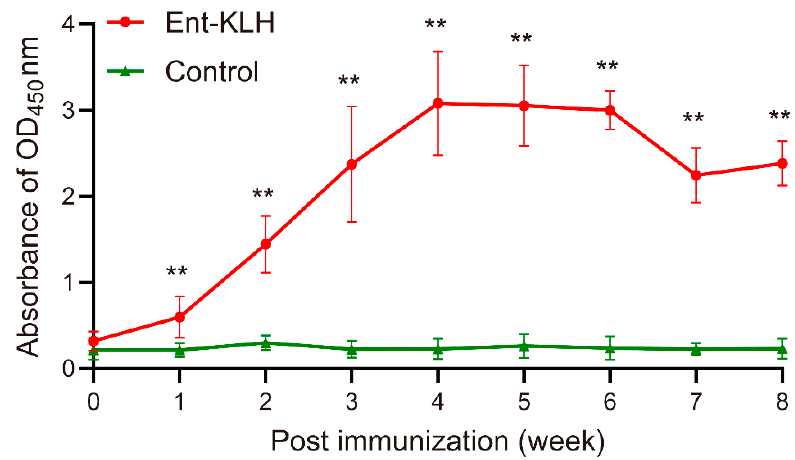
Figure 5. Persistence of Ent-specific IgG upon single vaccination of chickens with the Ent–KLH conjugate vaccine (Trial C). Each point represents the average of OD 450 absorbance from 20 individual serum samples (200-fold dilution) with standard deviation indicated by error bar. ** p <